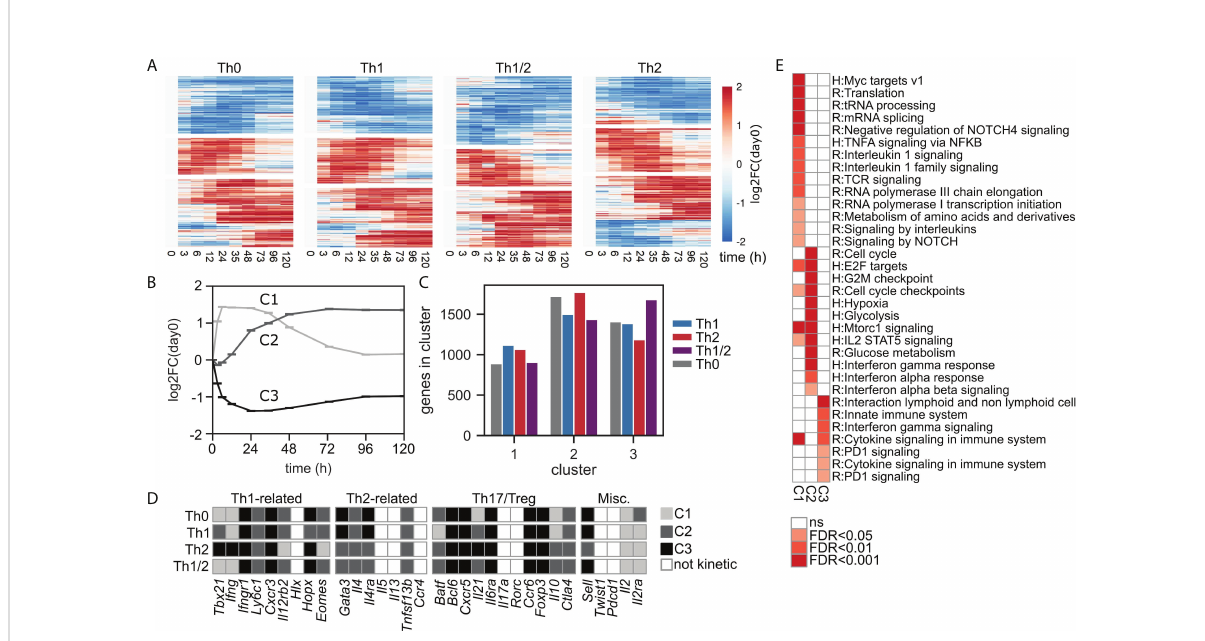
FIGURE 2 Early Th-cell differentiation features three major patterns of kinetic gene expression. (A) Expression heatmap for kinetic genes. (B) Normalized expression kinetics of the three identi fi ed kinetic gene expression clusters, shown as averages over all genes and all cell types contained in each cluster. (C) Quanti fi cation of the numbers of identi fi ed kinetic genes across cell types within each kinetic cluster. (D) Gene classi fi cation as non- kinetic or kinetic including cluster association, for the four groups of Th cell-related genes introduced in Figure 1C. (E) Pathway enrichment analysis for genes uniquely assigned to kinetic clusters C1 – C3. Pathways were pooled from REACTOME and Msigdb:Hallmark data bases; for a list of all enriched pathways see Table